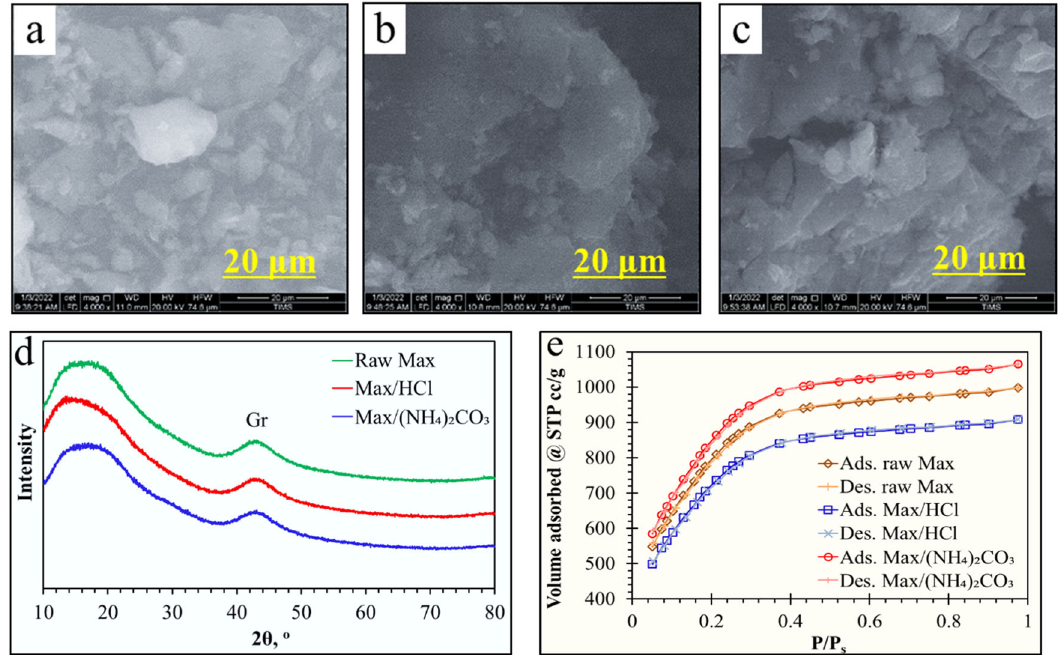
Fig. 2 Materials structure and porosity analysis. a SEM image of raw Max, b SEM image of Max/HCl, c SEM image of Max/(NH 4 ) 2 CO 3 , d XRD of Max samples, and e N 2 adsorption-desorption isotherms of raw and modi fi ed Max. No change can be observed Max structure. Max N 2 isotherms are closest to the I-Type, and the Max has microporous pore sizes.